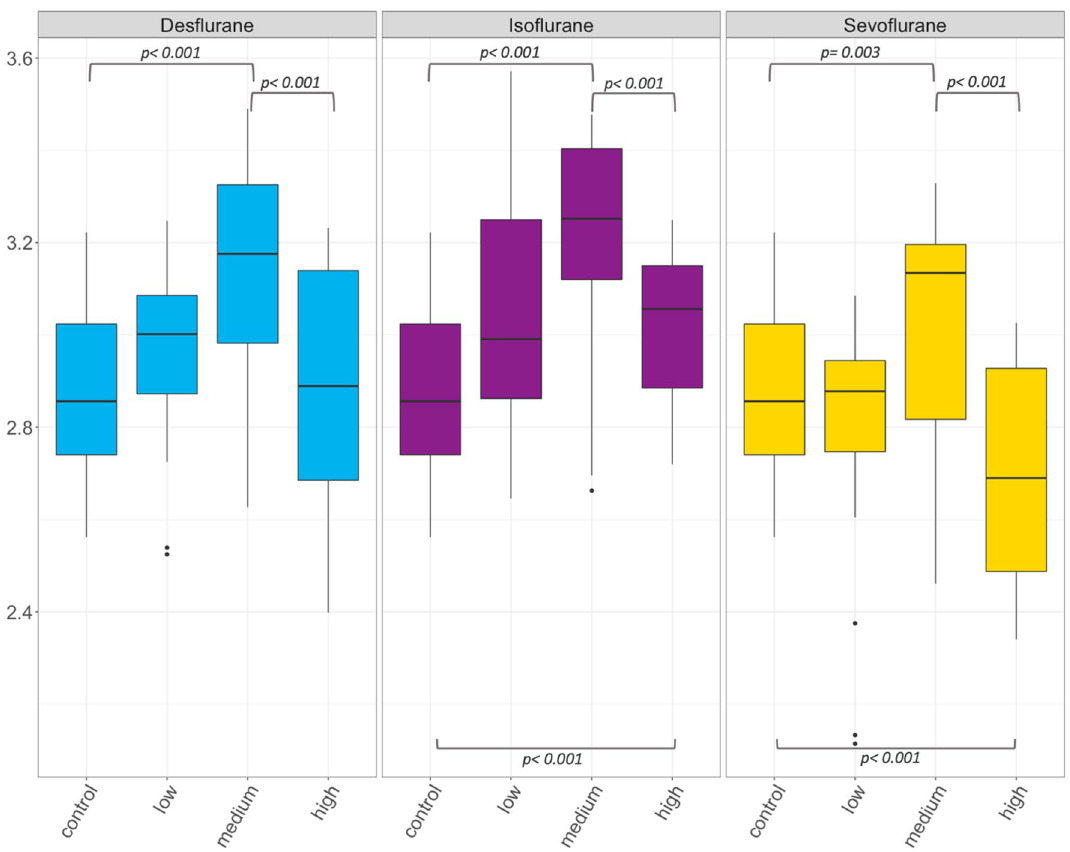
Figure 2. Box plots of HC for desflurane, isoflurane and sevoflurane at low (corresponding to MAC 0.5), medium (MAC 1.0) and high (MAC 2.0) concentration. Significant differences are indicated by brackets and p values are reported. HC is Hill